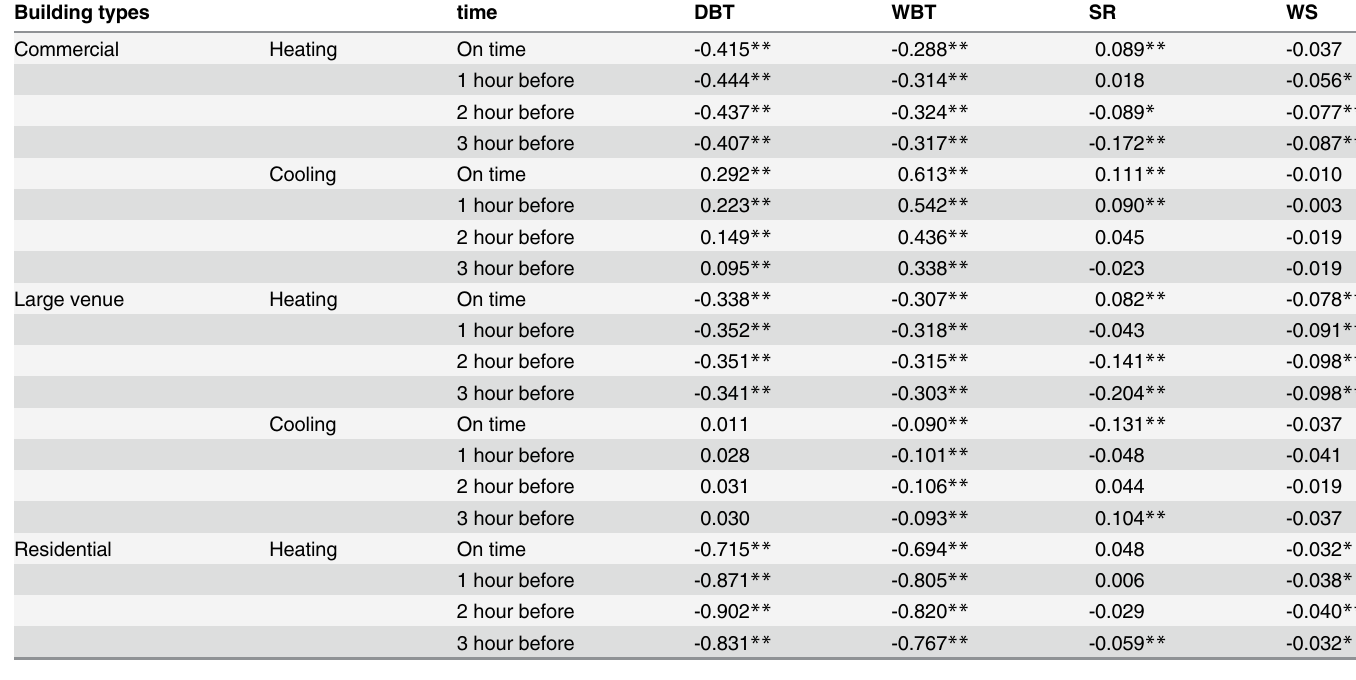
Table 6. Correlations between hourly extreme energy consumption for different types of buildings and climatic parameters. Building